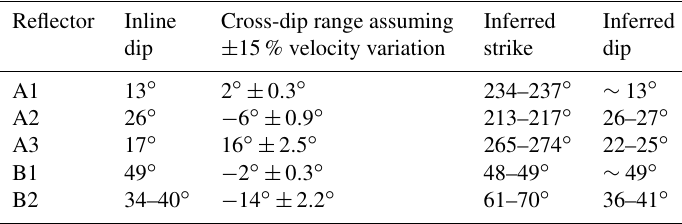
Table 2. Estimated strike and dip of the most prominent reflections. Reflector Inline Cross-dip range assuming